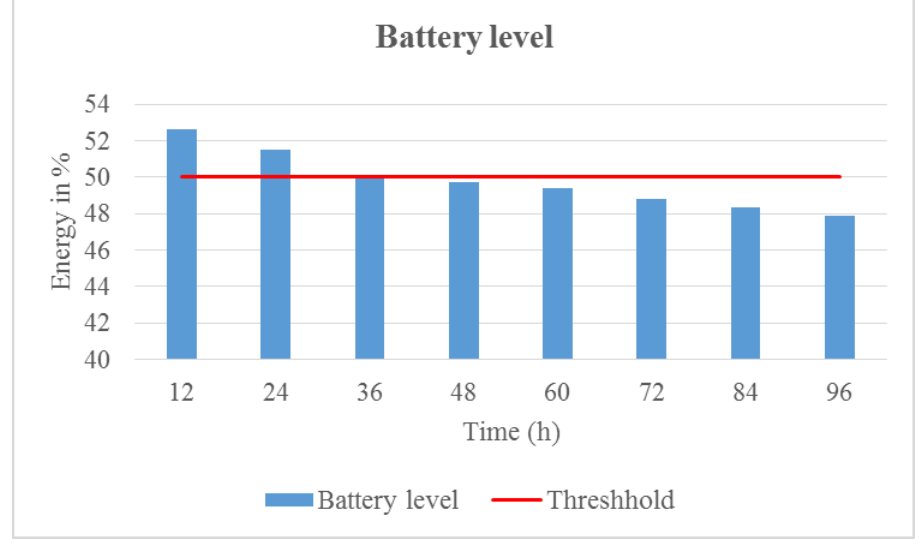
Figure 16. Battery level versus energy.